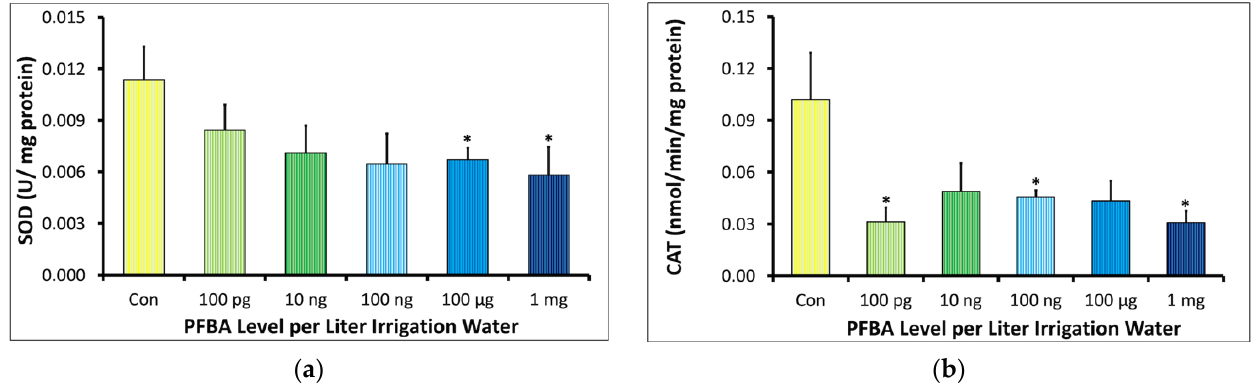
Figure 5. Dose–response relationship between concentration of PFBA in irrigation water and enzymes involved in detoxification of reactive oxygen species in leaves of soybean plant grown for 5 weeks. The * symbols indicate significant difference between the treatment and control at p < 0.05 and p < 0.01, respectively ( n = 3). ( a ) shows the superoxide dismutase (SOD) levels which decreased significantly in the 100 ng/L and 1 mg/L groups. ( b ) shows decreased catalase (CAT) levels in all treatment groups compared to the control.